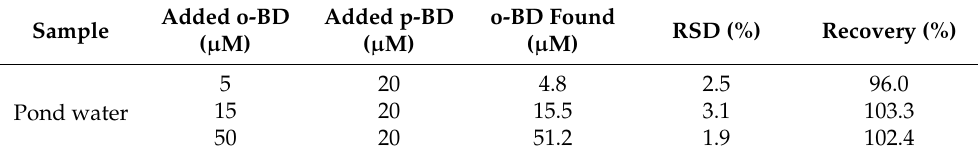
electrode. Figure S2: Cyclic voltammetry characterizations of different electrodes in buffer solution. Figure S3: The influence of pH value on electrochemical